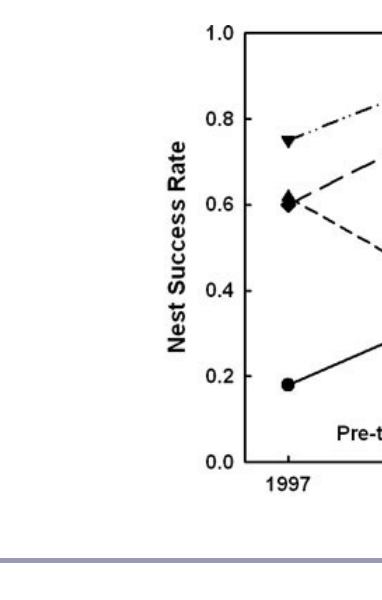
Fig. 5. Nest success rate for each year and treatment combination, for nest initiation date of 27 May and median water depth of 31 cm, for American Coot ( Fulica Americana ) nests at Grays Lake, Idaho during 1997–2000. Nest success rate was a model estimate based on a 27-day exposure